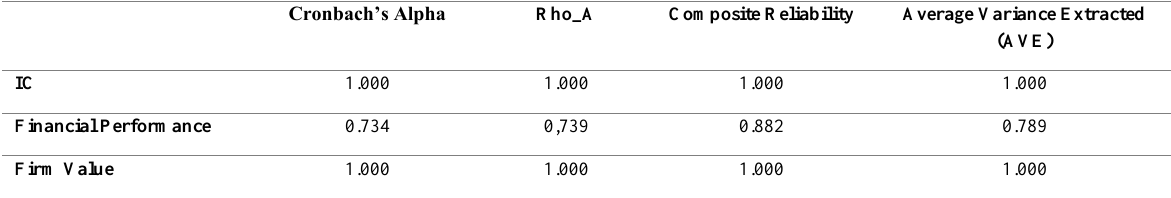
Table 1 : Output of Construct Reliability and